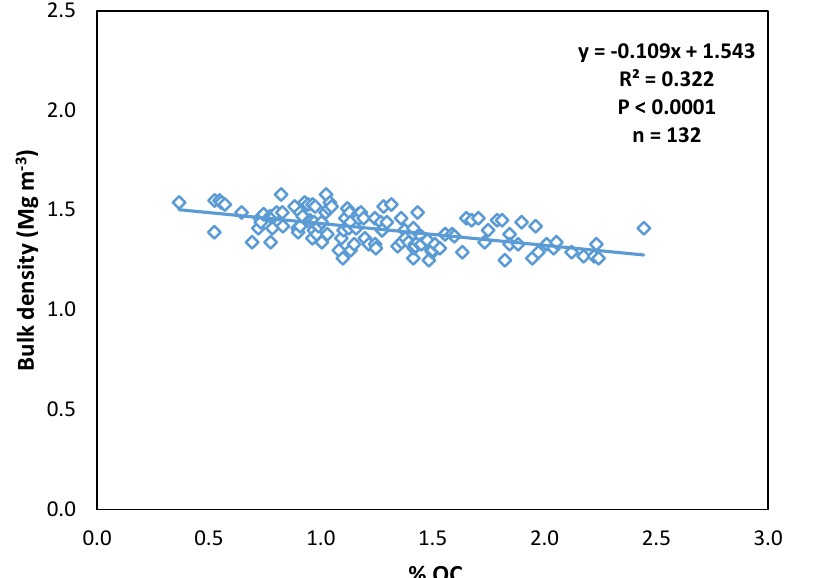
Figure A1. Relationship between organic carbon content (%OC) and bulk density for the 0–10 and 10–20cm soil layers collected in 1997 from all trial